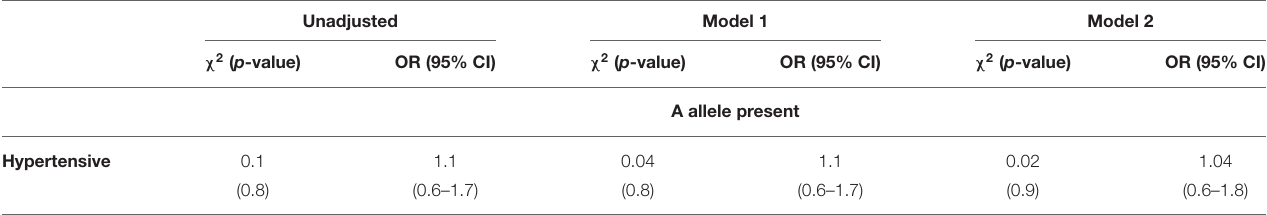
TABLE 8 | Hypertension status does not vary by presence of the KCNJ2 -A allele in unadjusted and adjusted models. Unadjusted Model